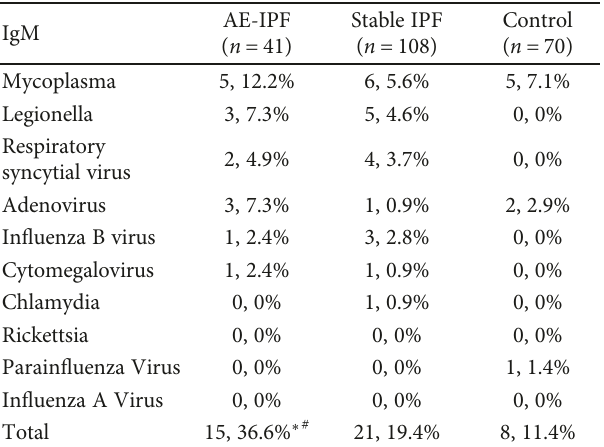
Table 3: Speci fi c IgM antibodies against 10 common pathogens (serum, number of positive cases, and positive rate).